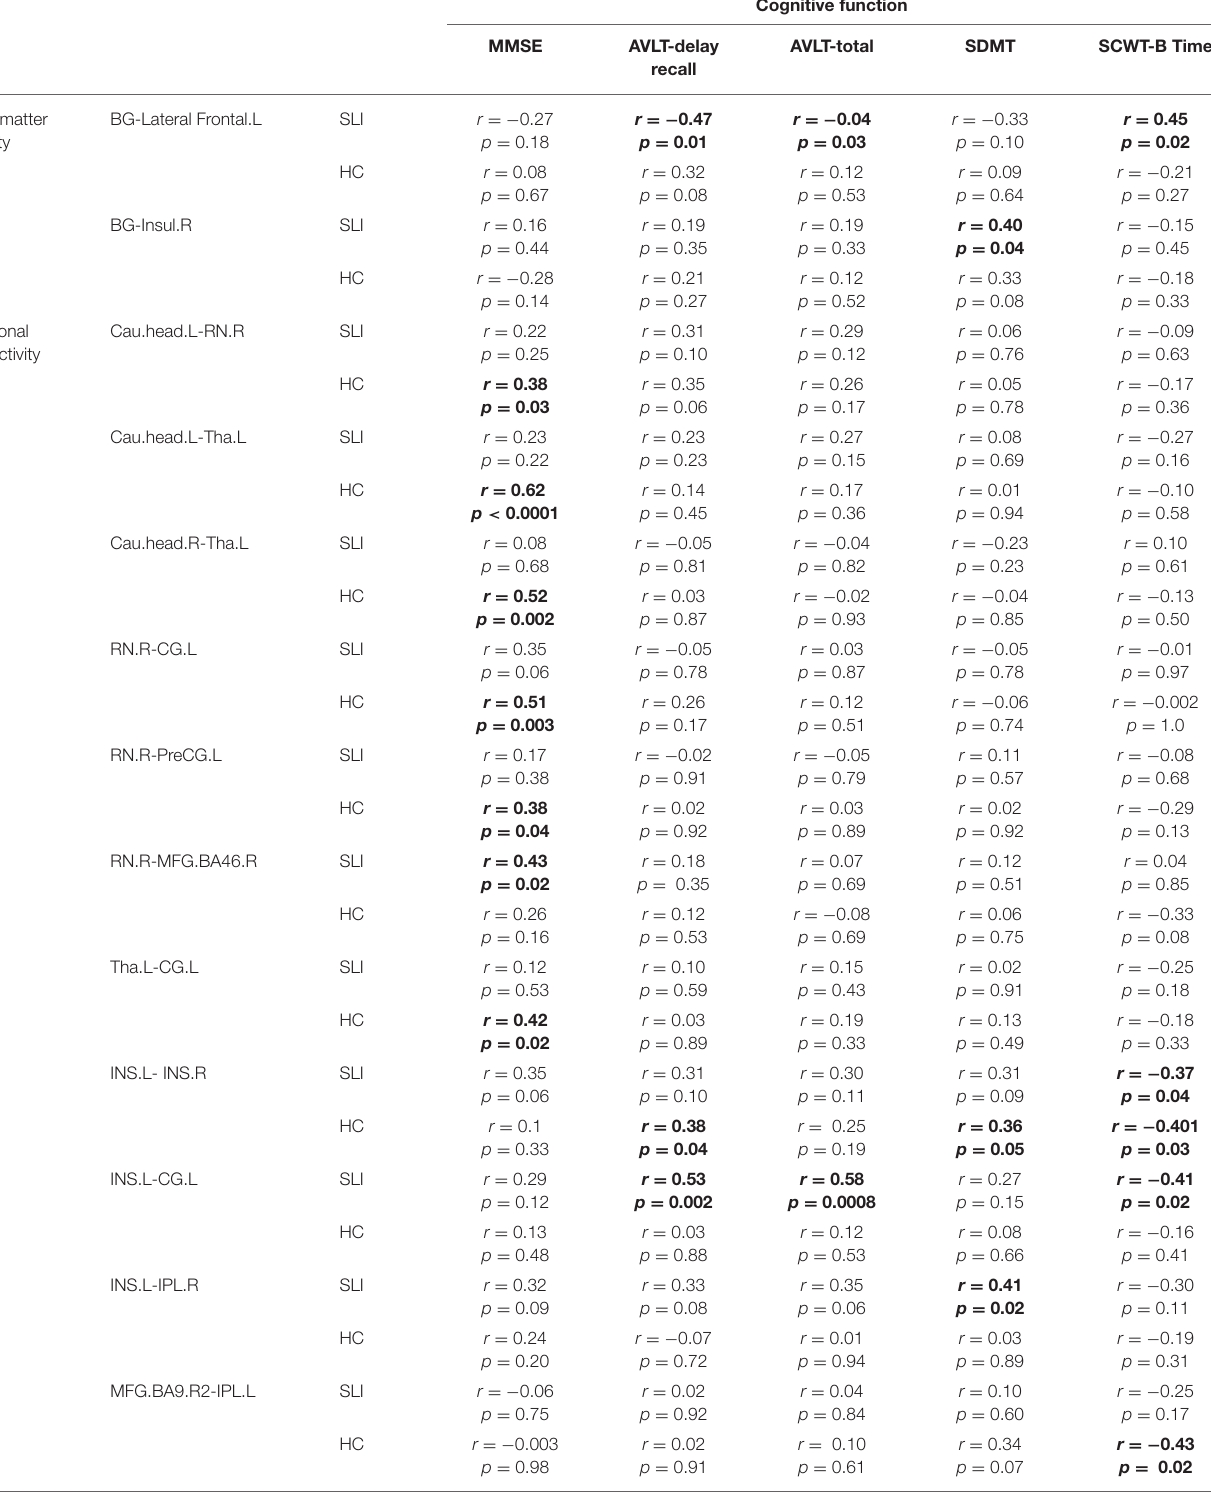
TABLE 3 | Correlation between BG-cortical connectivity and cognitive